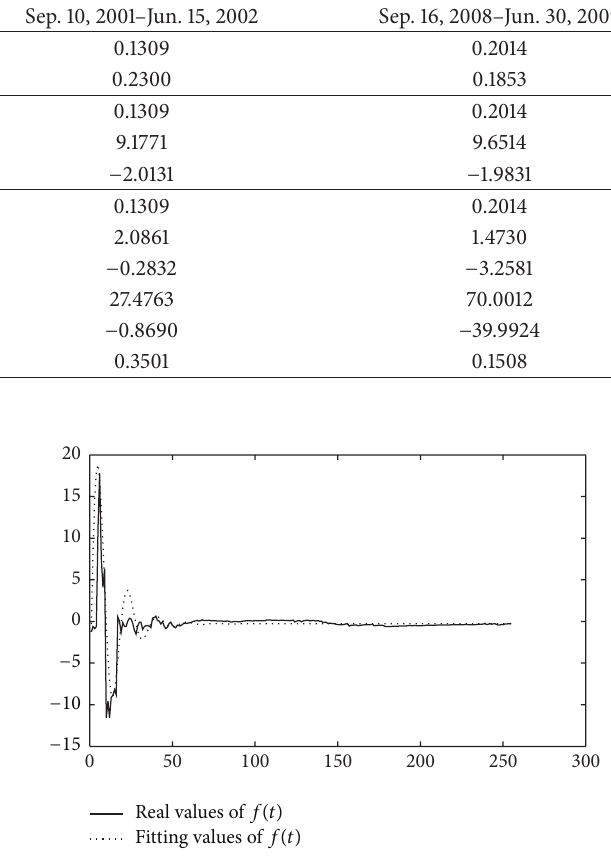
Figure5:Realvaluesversusfittingvaluesof 𝑓(𝑡) during“9/11”event.